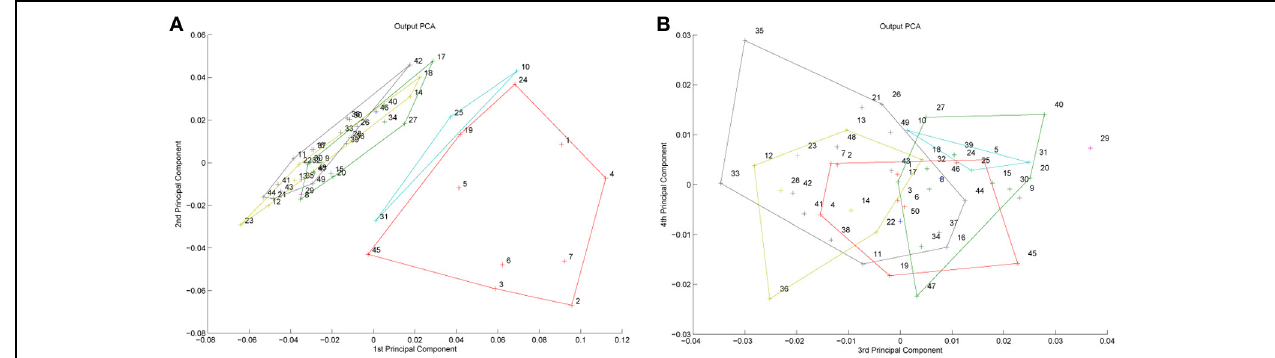
FIGURE 9 | (A) Output of the network projected onto its principal components. Outputs are labeled by a code corresponding to the specific input image which generated the output. Image numbers 1–7 correspond to the other-race faces. The colored “ + ” and corresponding subregions of output space represent the region of the space for which a specific neuron wins. Note that for the first two principal components, the other race faces are strongly separate from the same-race ones, and a single neuron has learnt to respond to any of these other-race faces. The subregion